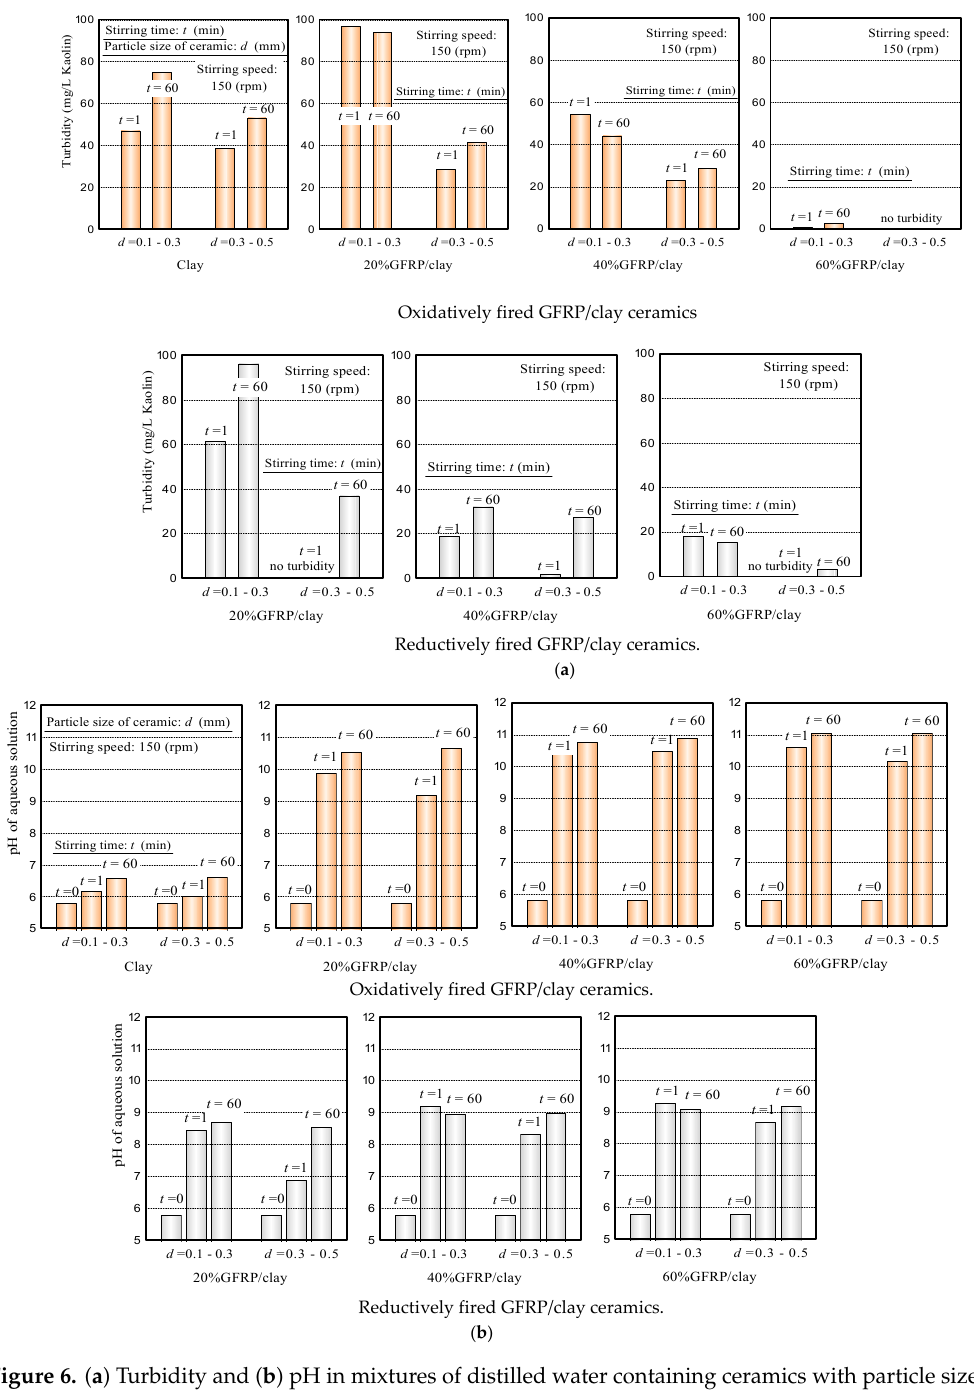
Figure 6. ( a ) Turbidity and ( b ) pH in mixtures of distilled water containing ceramics with particle sizes in the range of 0.1–0.3 mm and 0.3–0.5 mm, stirred at 150 rpm.